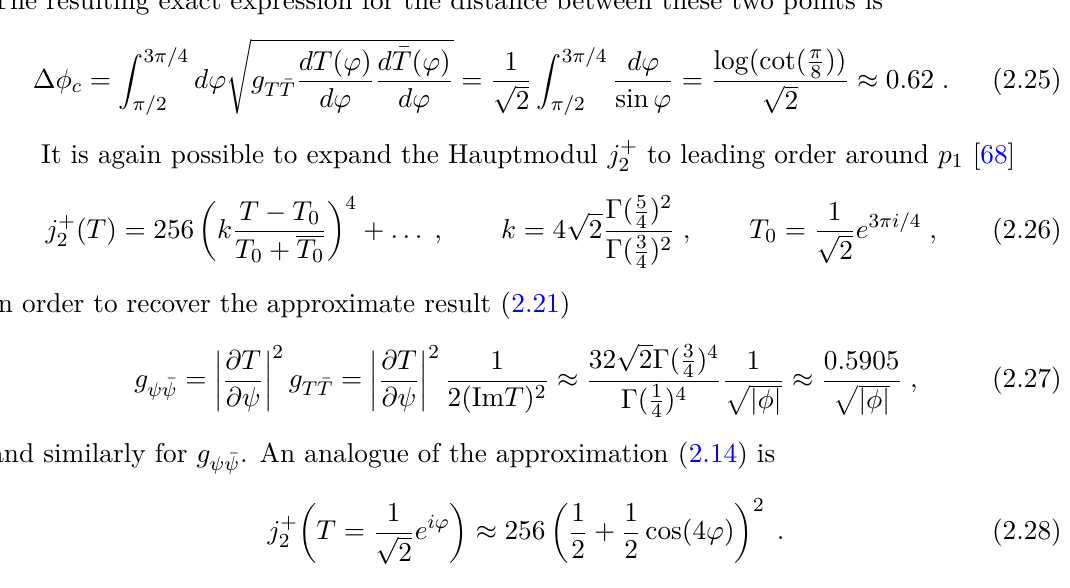
(2) + is obtained as X 0 (2) 0